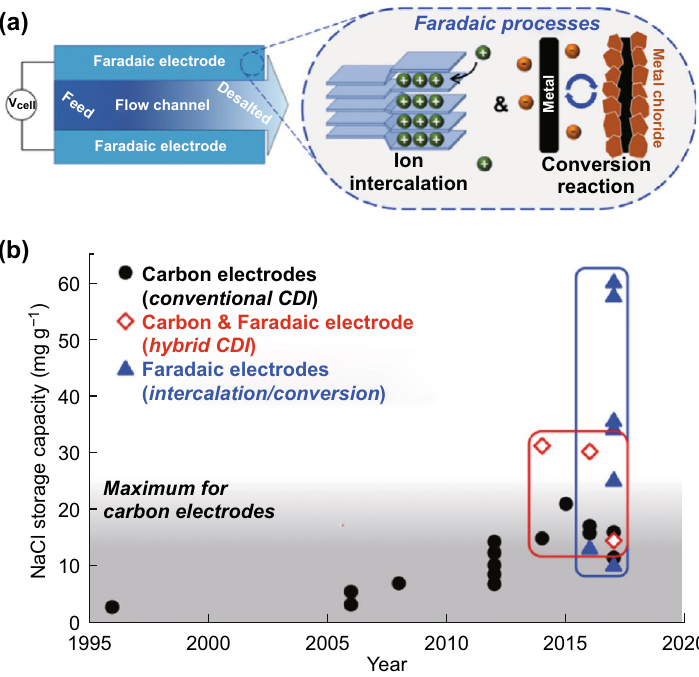
Fig. 12 Concept and performance values of capacitive deionization (CDI) cells with capacitive and Faradaic electrodes. Historical evolution of the salt storage capacity of desalination cells achieved with either nanoporous carbon electrodes (black circles), Faradaic electrodes (blue trian- gles), or hybrid cells with one nanoporous carbon electrode and one Faradaic electrode (red diamonds), with all values reported per mass of both electrodes. Despite their recent introduction, cells with Faradaic electrodes have achieved significantly higher gravimetric salt storage capacities compared with cells with nanoporous carbon electrodes. Schematics contrast the salt storage mechanism of CDI cells leveraging nanoporous car- bon (capacitive) electrodes and cells with Faradaic electrodes, such as layered intercalation electrodes or conversion electrodes [195]. Copyright 2017, Elsevier Inc. (Color figure